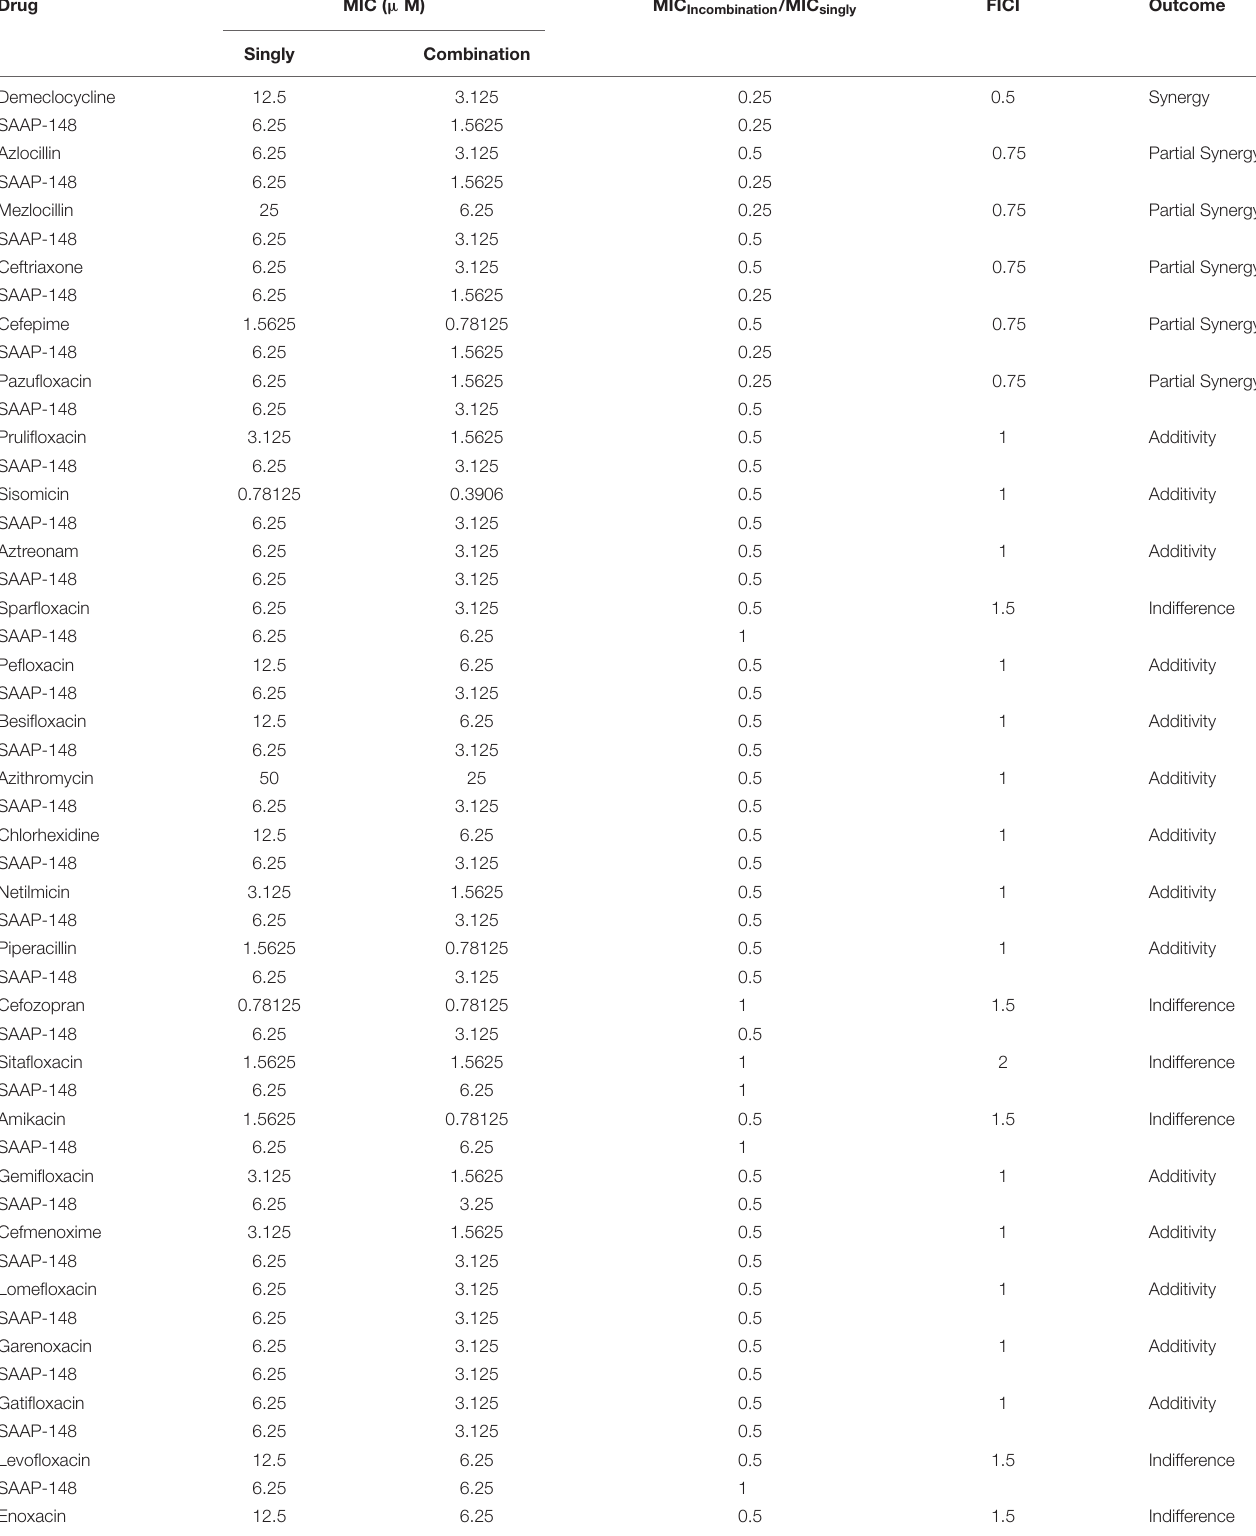
TABLE 3 | FICs of selected drugs and SAAP-148 alone or in combination against PAO1. Drug MIC ( µ M) MIC Incombination /MIC singly